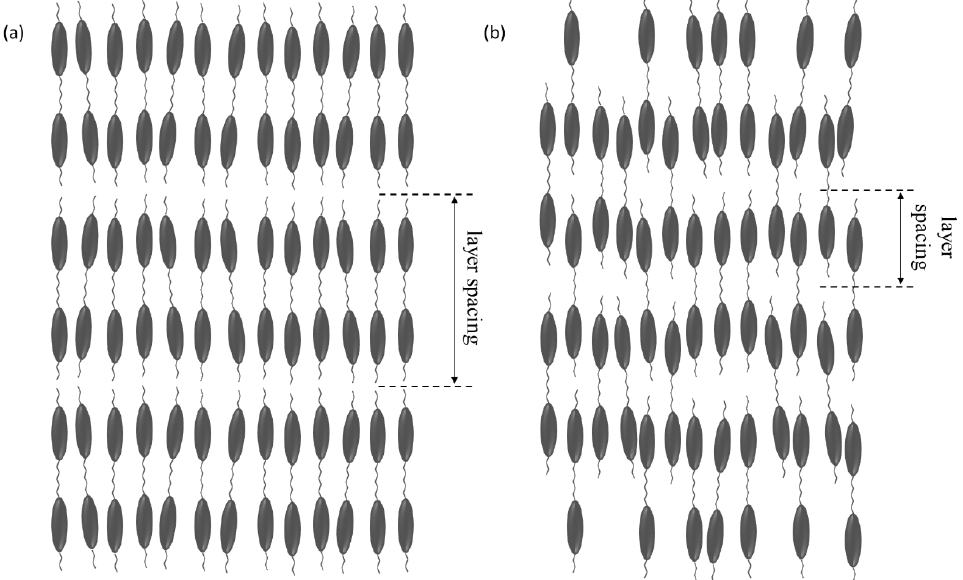
Figure 4. A sketch of ( a ) the monolayer smectic A phase ( d ~ l ) exhibited by symmetric liquid crystal dimers, and ( b ) the intercalated smectic A phase ( d ~ l/2 ) observed only rarely for symmetric liquid crystal dimers.